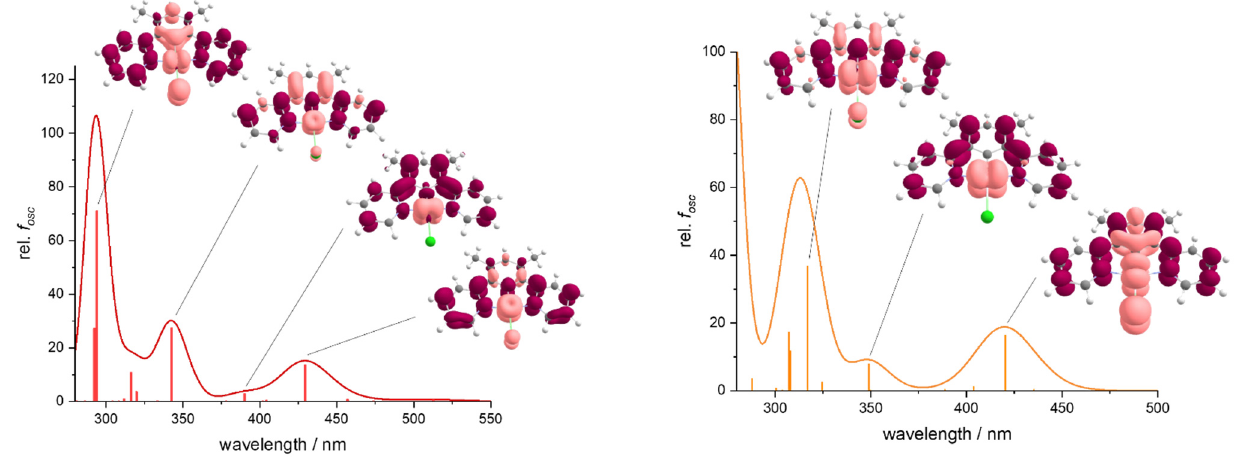
Figure 4. TD-DFT-calculated transitions for [M(Me 2 dpb)Cl] with M = Pt ( left ) and Ni ( right ), calculated at the TPSSh/def2- TZVP level of theory.